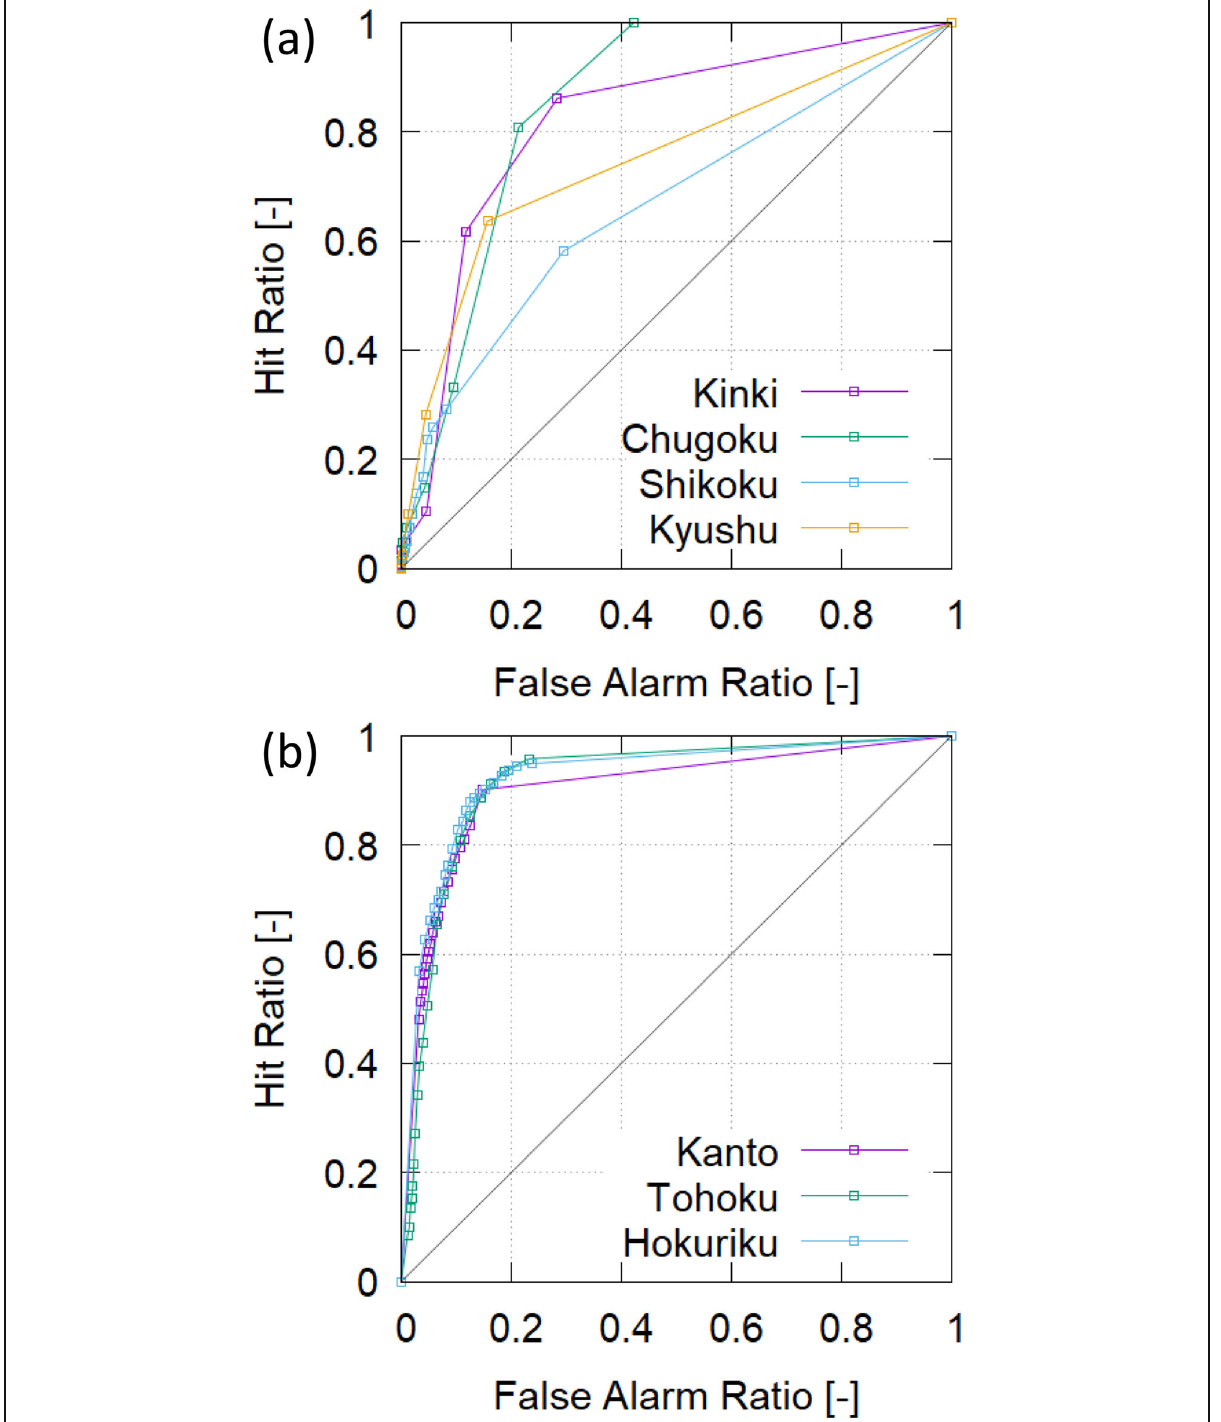
Fig. 9 ROC curves for a F18 and b T19. Ensemble forecasting is evaluated at all river grid-cells between the nowcasting and forecasting modes in each region performance. A line closer to the top left corner shows better performance of ensemble